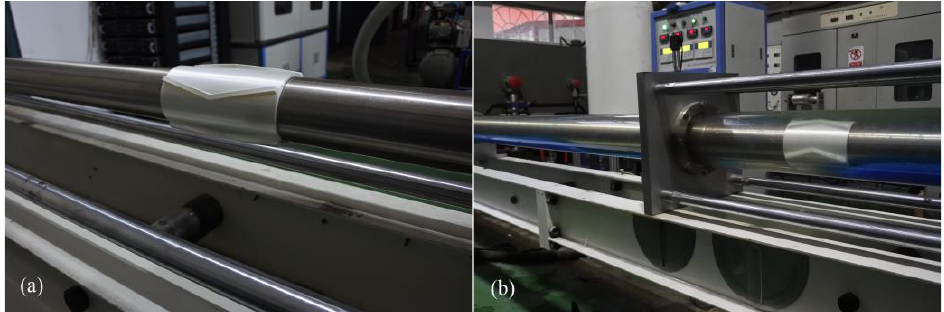
Figure 1. Experimental flow loop used to evaluate hole cleaning effect of V-shaped hole cleaning device. ( a ) Front view of the drill pipe, ( b ) back view of the annulus.